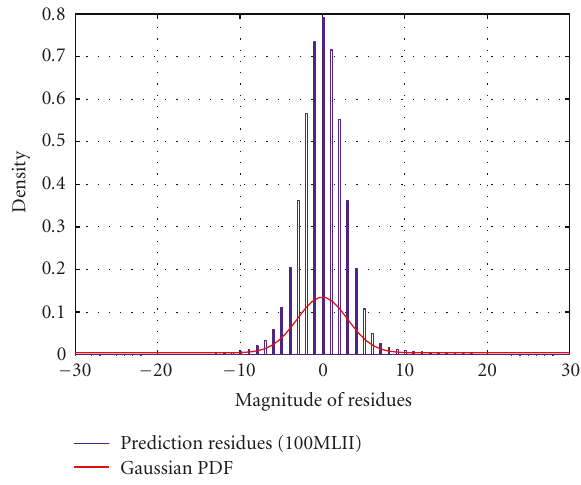
Figure 4: Overlay of Gaussian probability density function over the histogram plot of prediction residues for the MIT-BIH ADB record